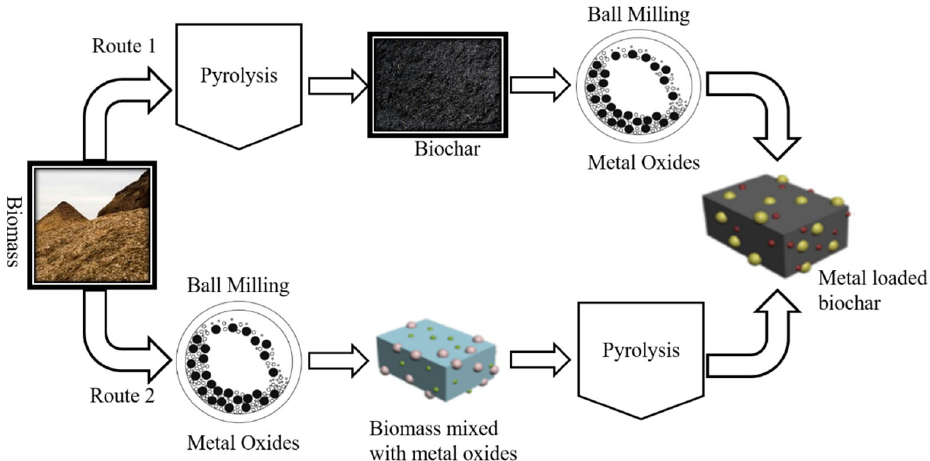
Figure 17. Two-way mechano-chemical method to produce metal oxide loaded BC-based material produced via pyrolysis. Recreated with permission from Ref. [26]. Copyrights © 2020 Elsevier B.V.